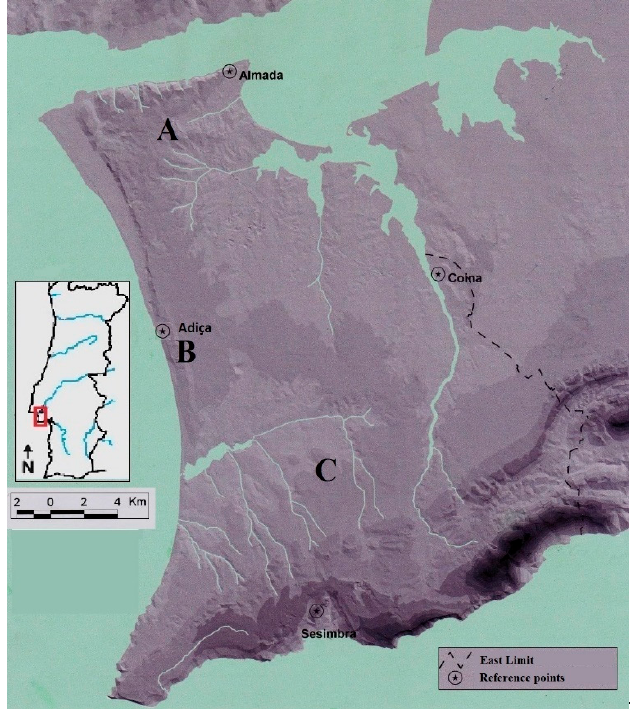
Figure 2. Territory administration. A) Setúbal Peninsula northern territory; B) Adiça gold mine; C) Setúbal Peninsula Southern territory.